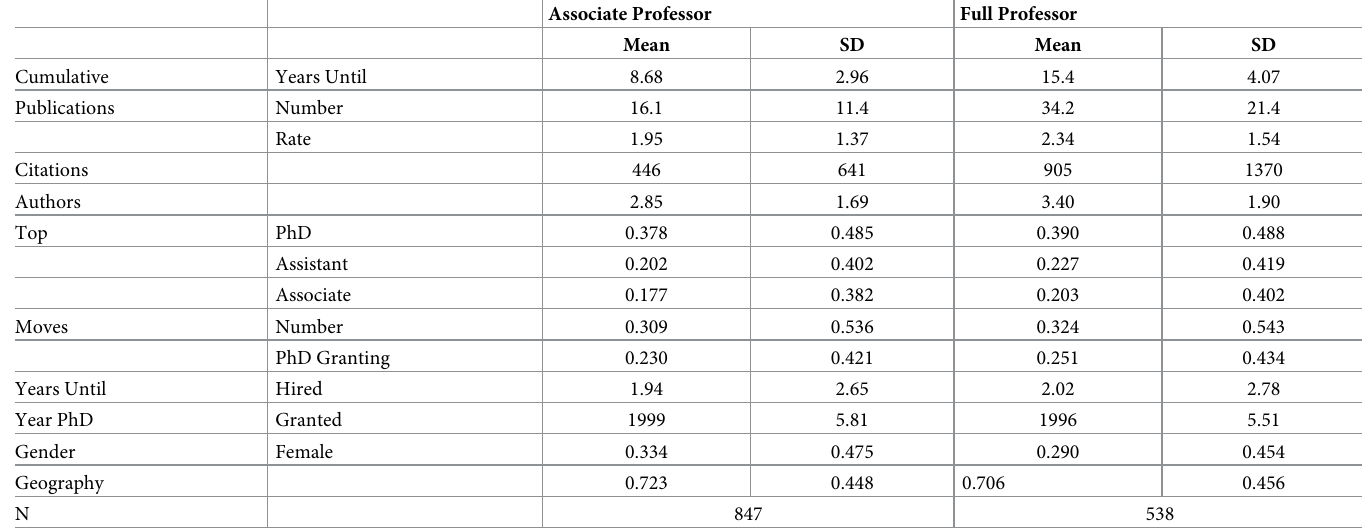
Table 4 summarized the study’s descriptive statistics. Promotion to associate professor after hiring occurs about 8.7 years after PhD granting or about 6.8 years after hiring which is close